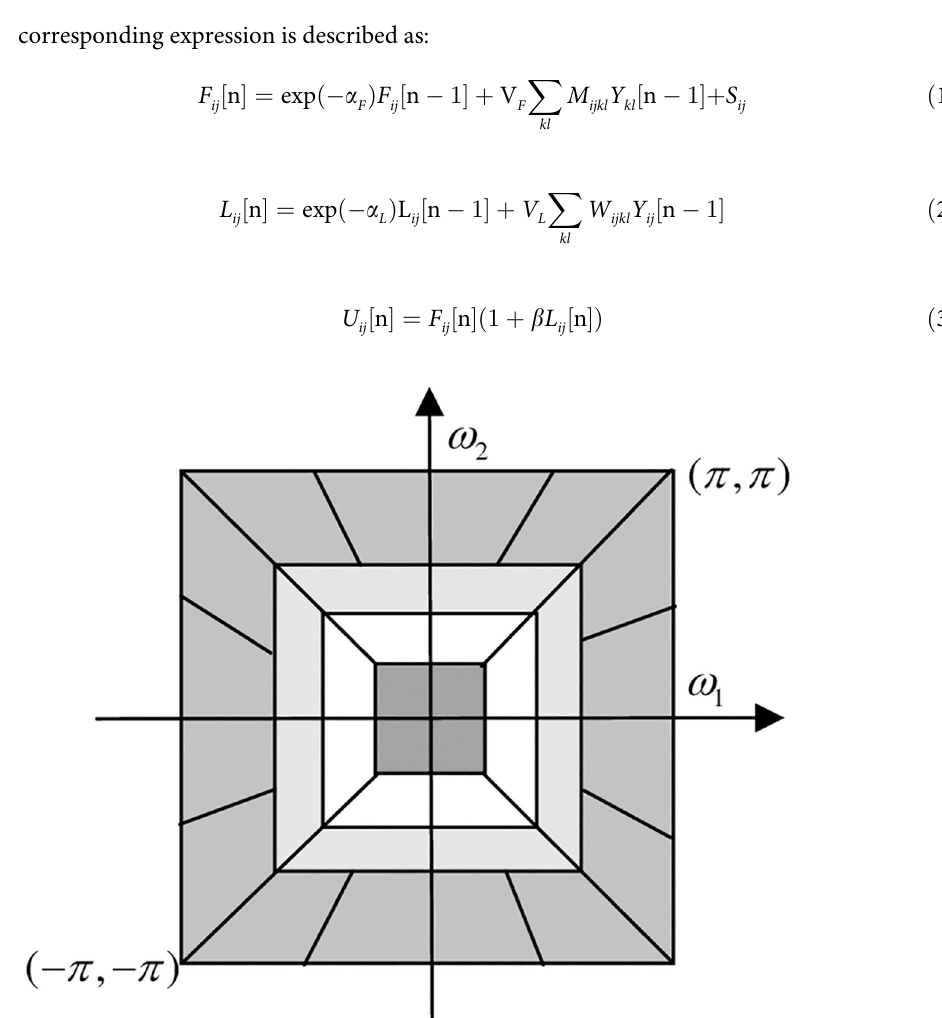
Fig 2. Schematic diagram of two-dimensional frequency